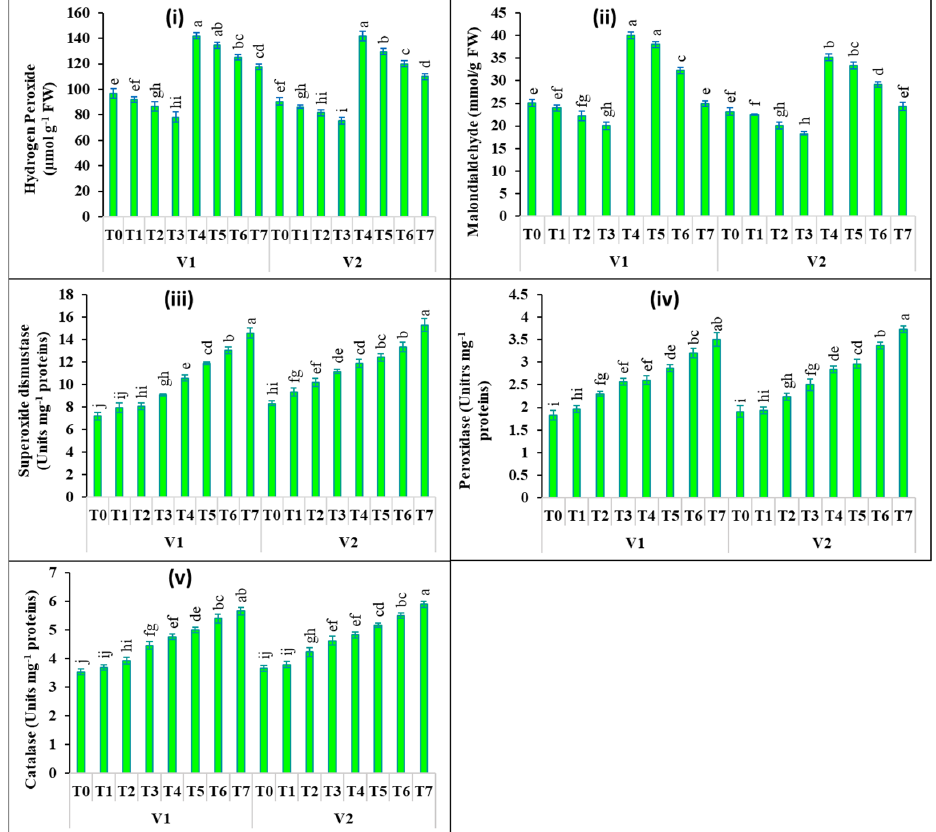
Figure 4. Influence of salicylic acid priming on ( i ) hydrogen peroxide/H 2 O 2 , ( ii ) malondialde- hyde/MDA, ( iii ) superoxide dismutase/SOD, ( iv ) peroxidase/POD, and ( v ) catalases/CAT under salt stress; T0 (control), T1 (hydropriming), T2 (10 mM SA priming), T3 (20 mM SA), T4 (170 mM NaCl), T5 (170 mM NaCl + hydropriming), T6 (170 mM NaCl + 10 mM SA priming), and T7 (170 mM NaCl + 20 mM SA priming); bars sharing same case letter or without lettering, for a parameter, do not significantly differ ( p ≤ 0.05) by the LSD test.